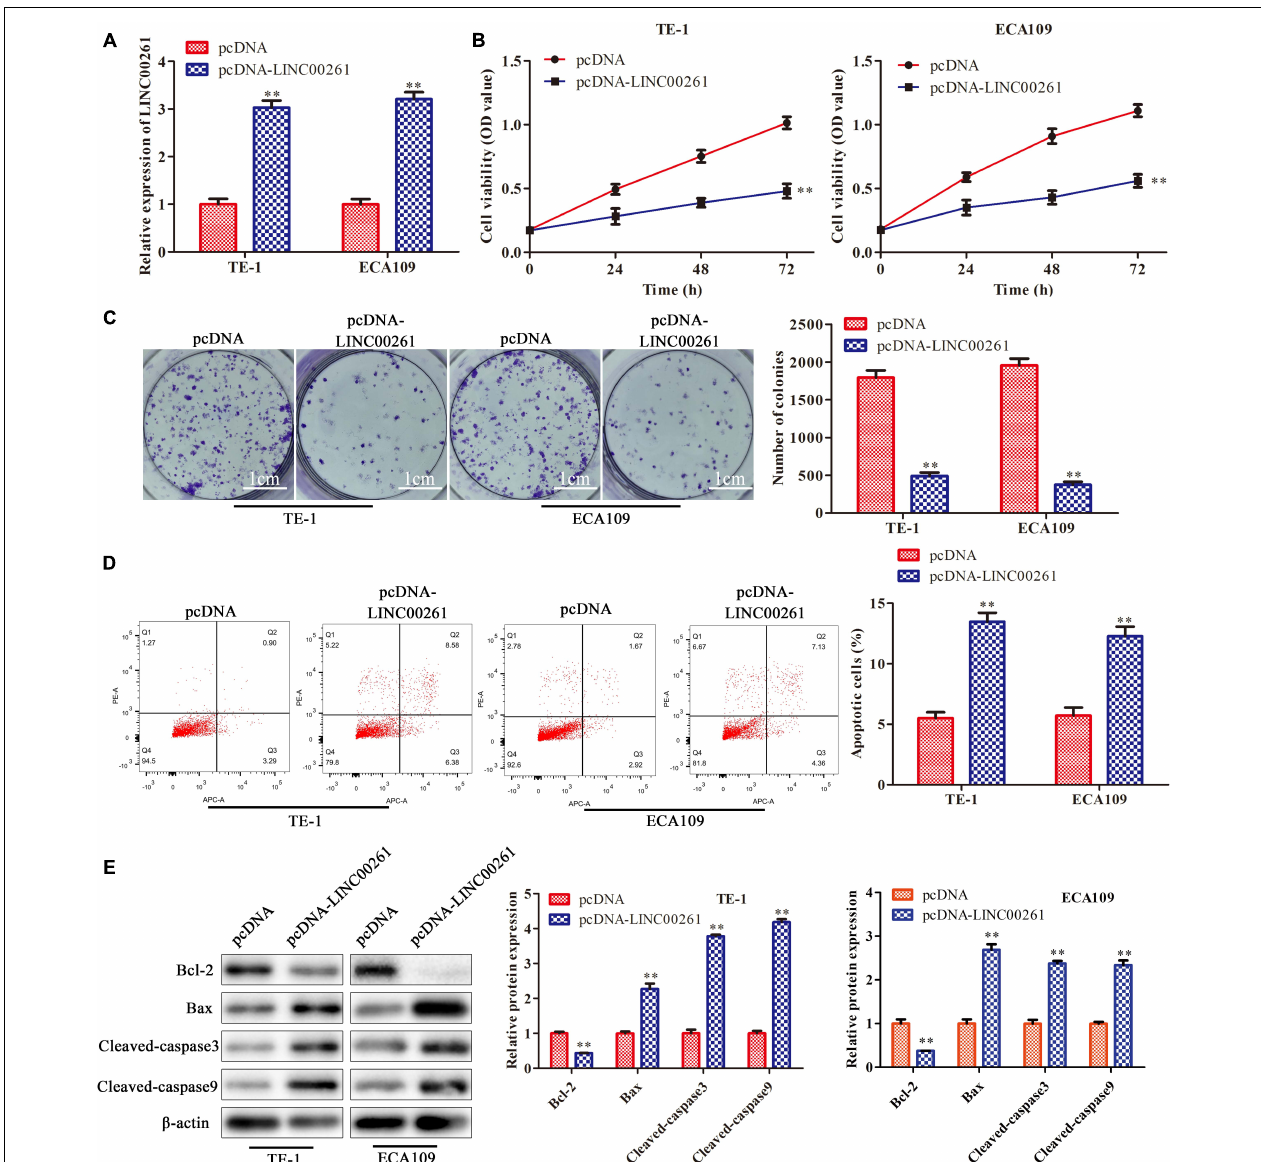
FIGURE 2 | Overexpression of LINC00261 inhibits the proliferation and promotes apoptosis of ESCC cells. TE-1 and ECA109 cells were transfected with pcDNA-LINC00261 and pcDNA. (A) The expression of LINC00261 detected by RT-qPCR. (B) The proliferation assessed by CCK-8 assay. (C) The proliferation measured by clone formation assay. (D) The apoptotic cell detected by flow cytometry assay. (E) The apoptosis-relate protein detected by western blot in TE-1 and ECA109 cells. ** P < 0.01 compared with the corresponding control